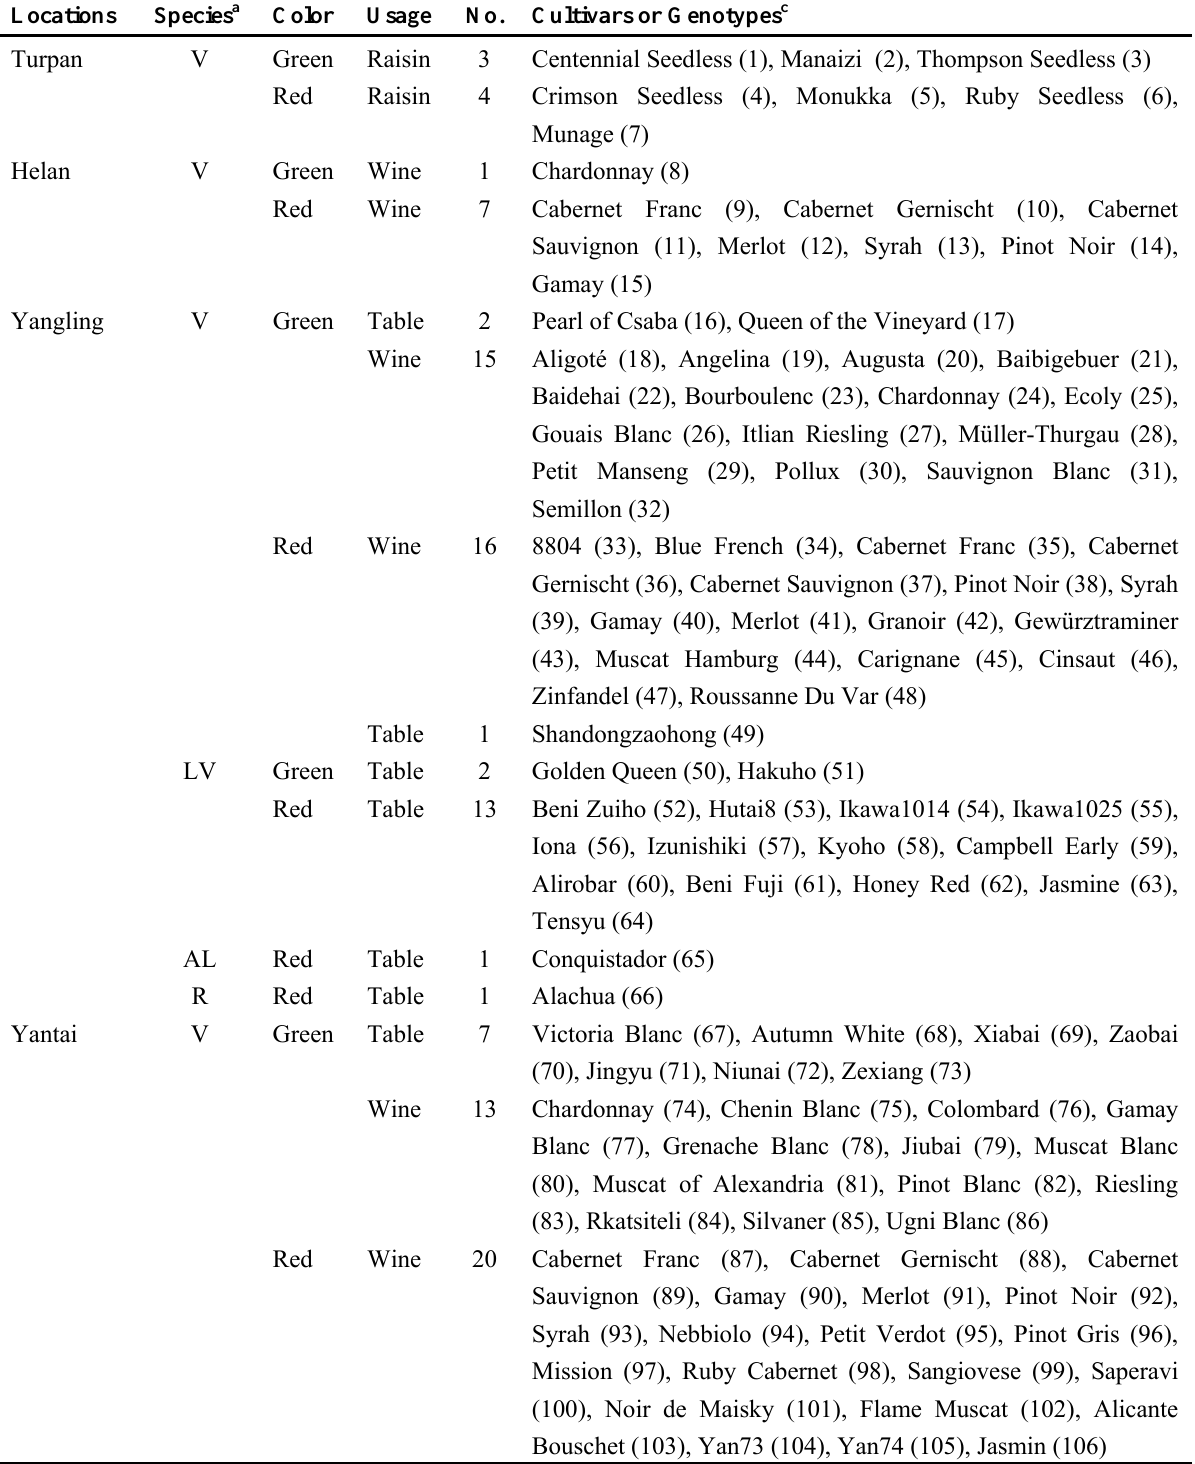
Table 1. Locations and characteristics of grape cultivars used in this study.